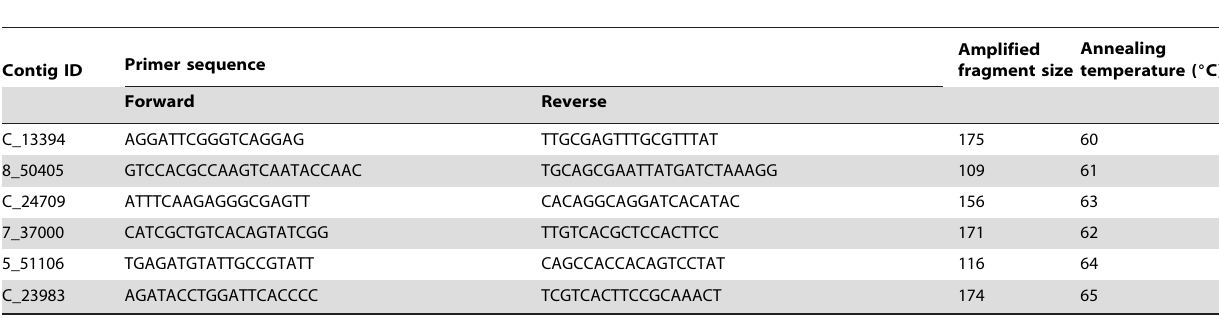
Table 4. Forward and reverse primers designed based on the DNA-sequence of